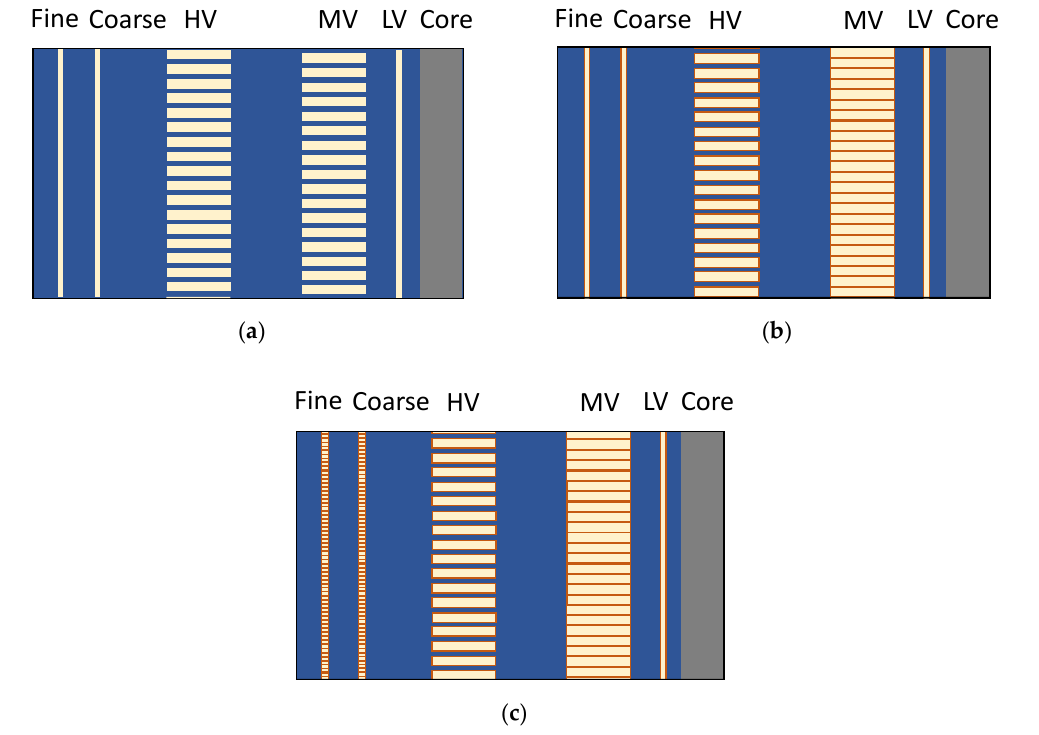
Figure 1. Cross-sectional view of the different winding designs (conductors in yellow, oil in blue, and oil-impregnated paper in orange). ( a ) Reference winding design with insulation layer defined as a coating (not visible); ( b ) Second winding design with reduced oil-filled gaps in the medium-voltage (MV) winding; ( c ) Third winding design with individually modeled turns in the coarse and fine windings.